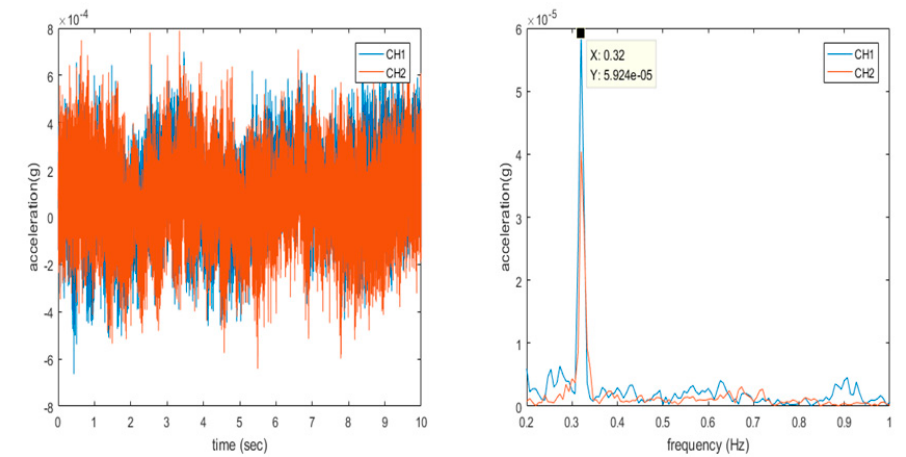
Figure 20. Time series of acceleration and response spectrum of the wind turbine system.